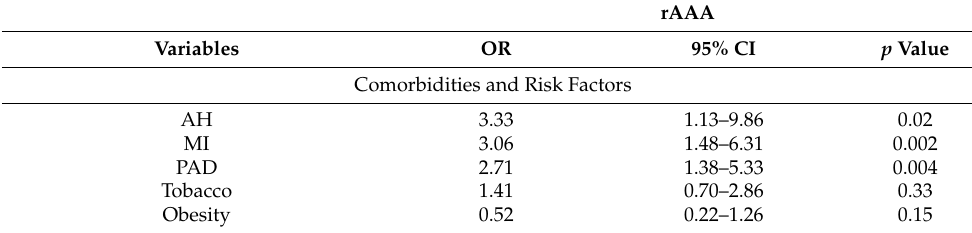
Table 5. Multivariate analysis for predictors AAA